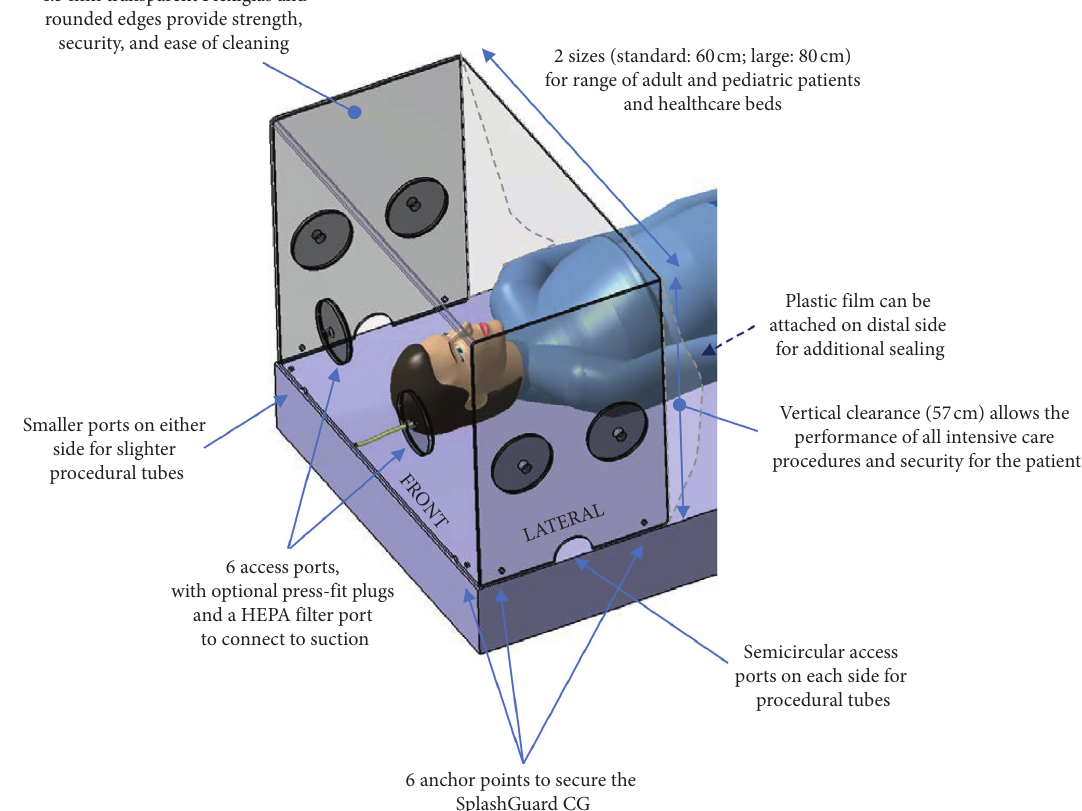
Figure 2: Features of the final prototype of the SplashGuard